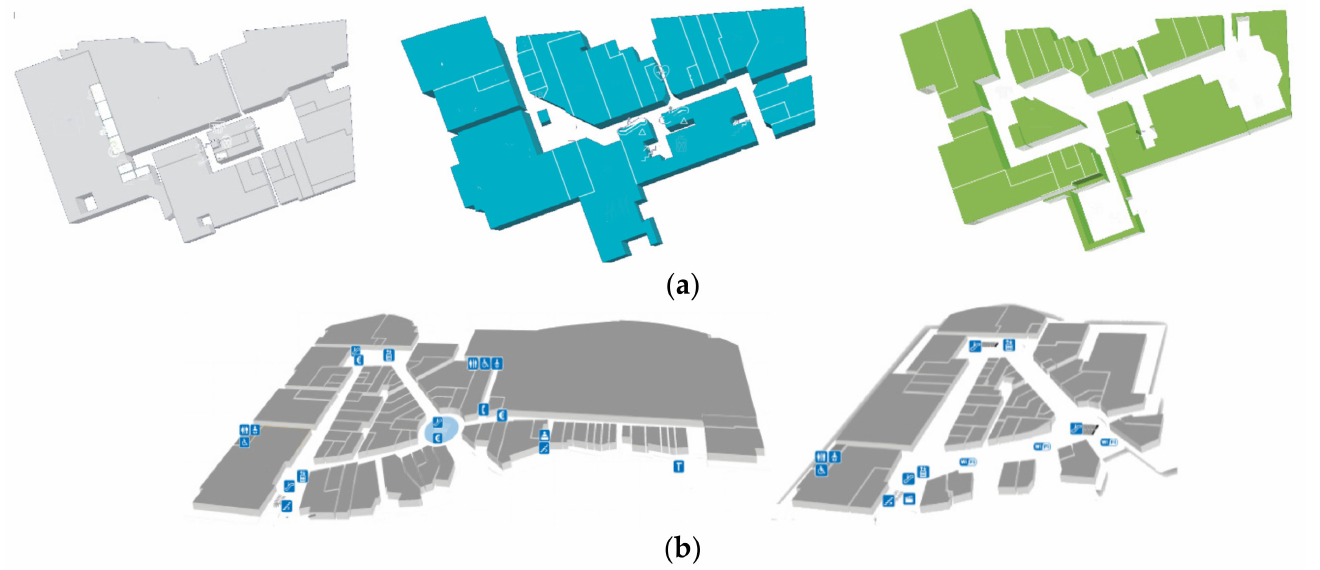
Figure 5. ( a ) Mall 1: ground floor ( left ), first floor ( center ), and second floor ( right ). ( b ) Mall 2: ground floor ( left ) and first floor ( right ).